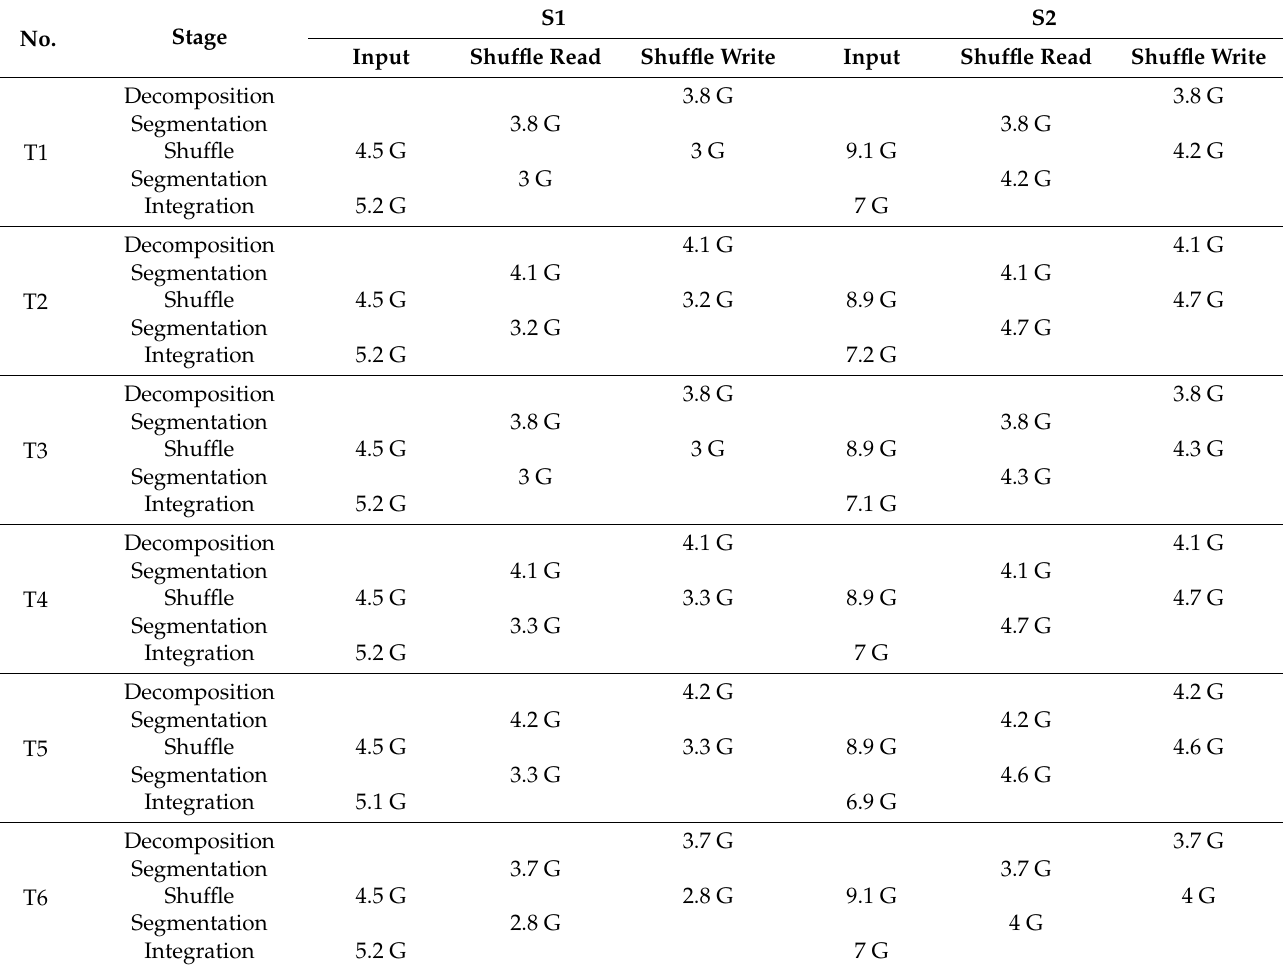
Figure 12. The improvement ratio of the elapsed time and data volume transmission in our strategy. Table 7. The data volume variations during in different processing stages.